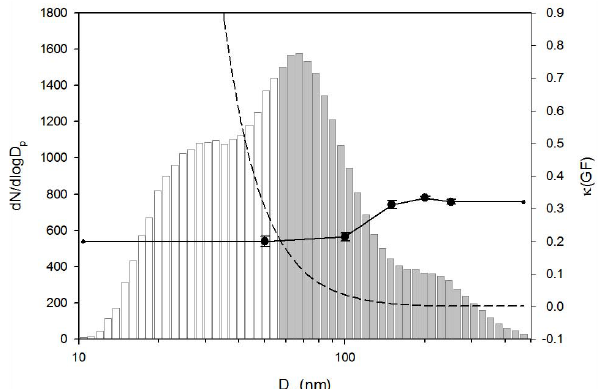
Fig. 11. Hygroscopicity parameter κ for each D dry during Gosan 2008. κ (GF) and κ ( S c ) are calculated from measured GF and S c values, respectively. Threshold κ values for CCN activation under selected S are shown as colored squares. The horizontal bar within the box indicates the median value and the upper and lower ends of the box represent 75 and 25 percentiles, respectively. The upper and lower whiskers outside the box represent 90 and 10 percentiles, respectively. Data outside of the 10–90 percentile range are consid- ered outliers and each data point is marked with an open